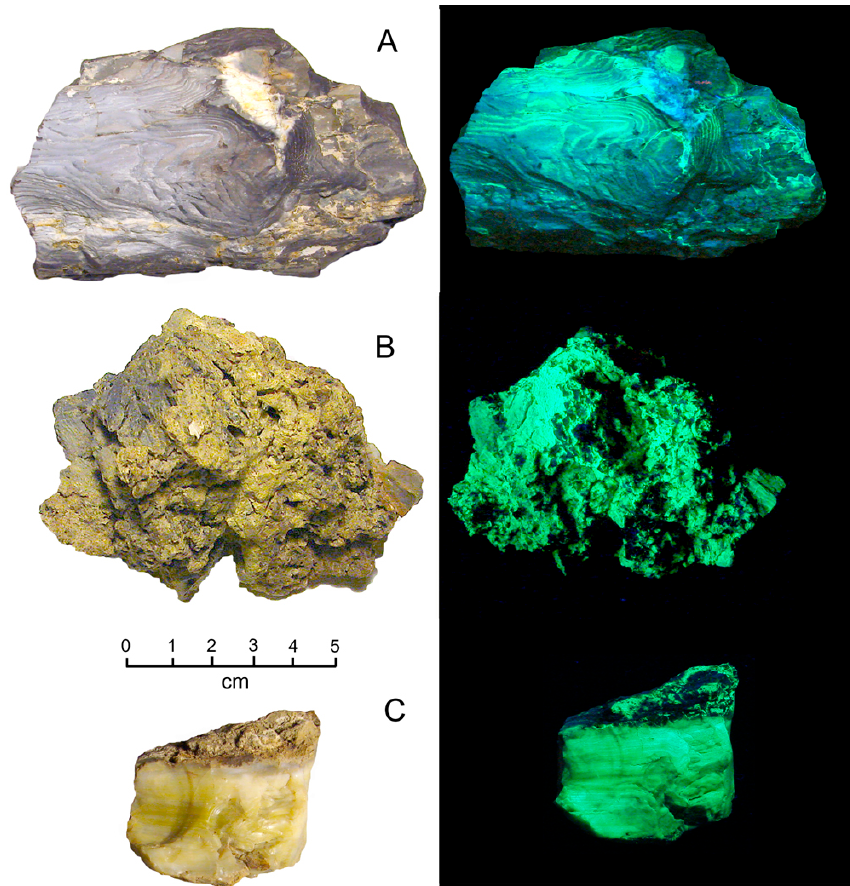
Figure 29. Uraniferous fossil wood from Bubbles Claim. Mineral County (NV). Photos on right show fluorescence under short-wave UV light. ( A ) Opalized wood showing well-preserved grain pattern. ( B ) Assemblage of small wood fragments cemented by common opal. ( C ) Wood mineralized with common opal.